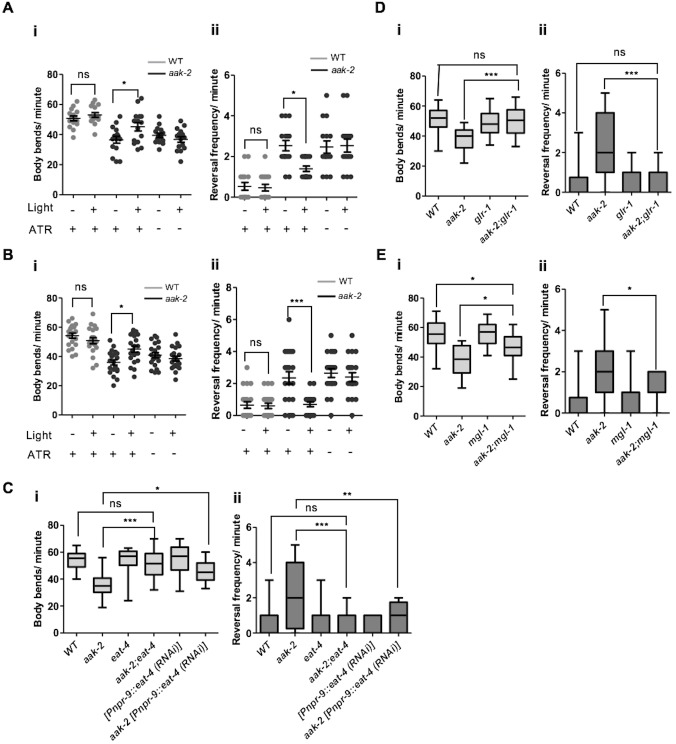
AMPK regulates glutamatergic signalling.(A,B) ChR2-mediated activation of AIY interneurons (A), or ARCH -mediated silencing of AIB interneurons (B) in starved aak-2 mutants grown in the presence of all-trans retinal (ATR) induces distal exploration by suppressing reversals and inducing forward locomotion (n>15), Error bars represent ± SEM (two-way ANOVA *p<0.05, ***p<0.0001). (C,D,E) Compromised eat-4, glr-1 or mgl-1 function rescues the defective exploratory behaviour of starved aak-2 mutants by inducing forward locomotion (i) and suppressing reversals (ii) (n>20), (one-way ANOVA *p<0.05, **p<0.001, ***p<0.0001). In the box and whisker plots (C,D,E) the central line is the median, the edges of the box are the 25th and 75th percentiles, and the whiskers extend to the most extreme data points.DOI:
http://dx.doi.org/10.7554/eLife.16349.01210.7554/eLife.16349.013Figure 3—source data 1.Optogenetics and epistatic analysis.DOI:
http://dx.doi.org/10.7554/eLife.16349.01310.7554/eLife.16349.014Figure 3—source data 2.The analysis of locomotory behaviour of potential AMPK phospho targets.DOI:
http://dx.doi.org/10.7554/eLife.16349.01410.7554/eLife.16349.015Figure 3—source data 3.Potential AMPK phosphorylation targets expressed within the AIB and AIY interneurons.